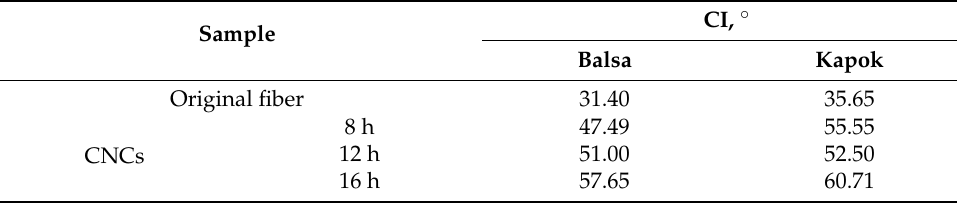
Table 3. Crystallinity indices (CIs) of the balsa and kapok fibers and of the resulting CNCs.